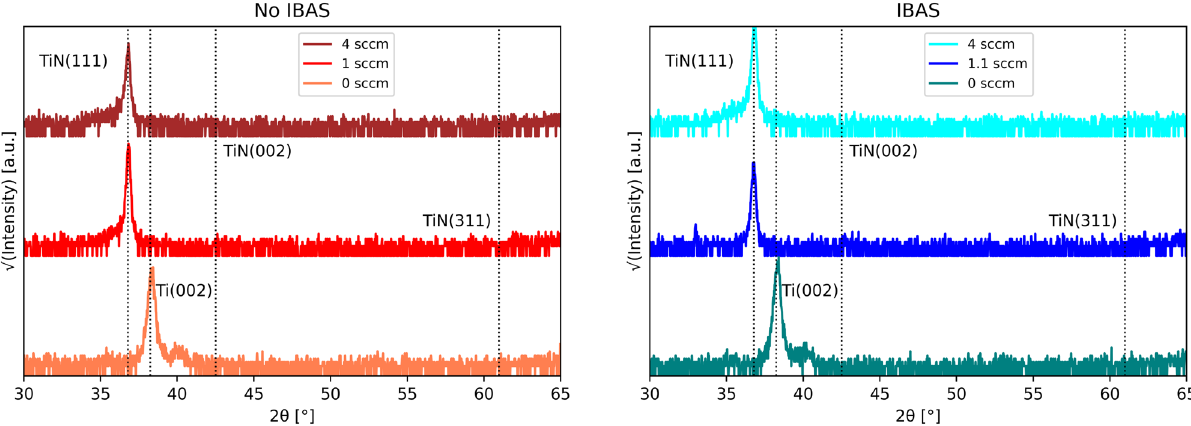
2 θ scans of 300 nm TiN films grown at room temperature via conventional reactive Figure 2. XRD ω − magnetron sputtering (left) and IBAS growth method (right) at varying nitrogen flow rates. TiN (111) is the primary orientation selected and Ti (002) is grown with no nitrogen added during